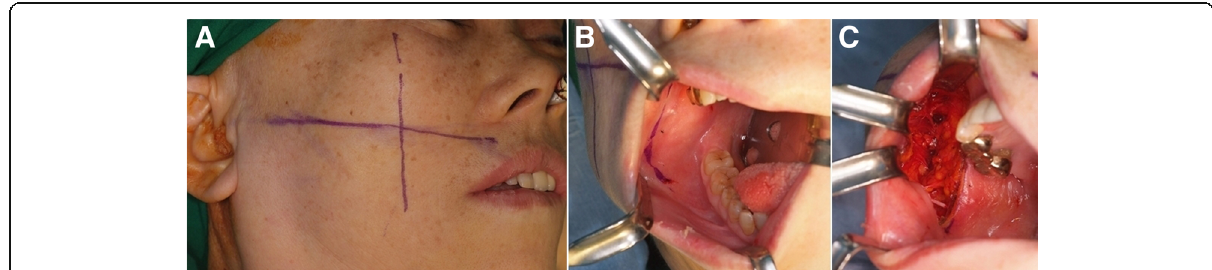
Fig. 1 Clinical photographs showing the facial reanimation technique using per-oral cross-facial sural nerve graft. a Crossed lines were first drawn on the face to identify the closest point between the parotid duct and the buccal branch. b A 4-cm vertical incision line was drawn on the cheek buccal mucosa approximately 5 mm anterior to the parotid papilla. c Dissection was performed through the buccinator muscle, buccal fat pad, and posteriorly along the parotid duct to identify the buccal branch